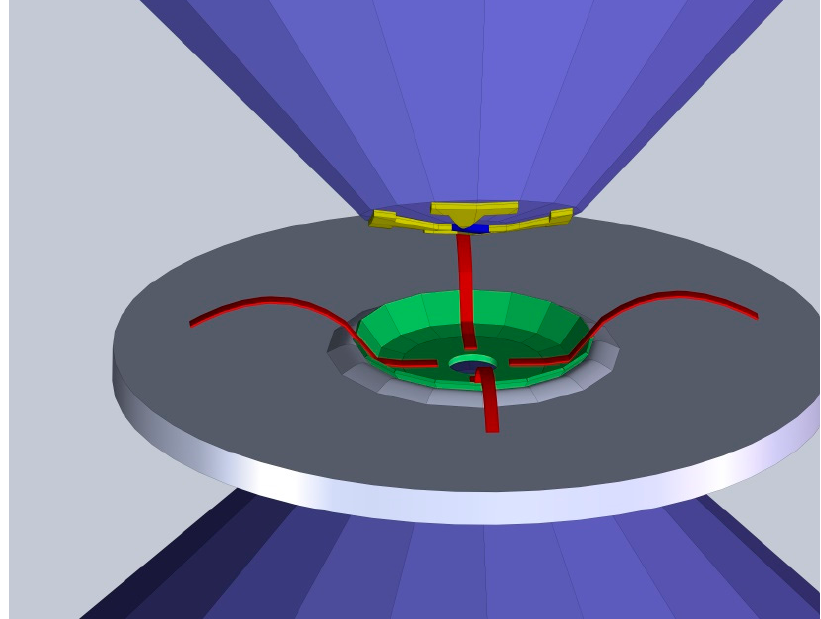
Figure 1. The schematic view of the Architecture Tech for High-Pressure Experiments Net Assembly (ATHENA) package, where red and yellow show the outer and inner electrodes, respectively, while the sample is shown in deep blue.